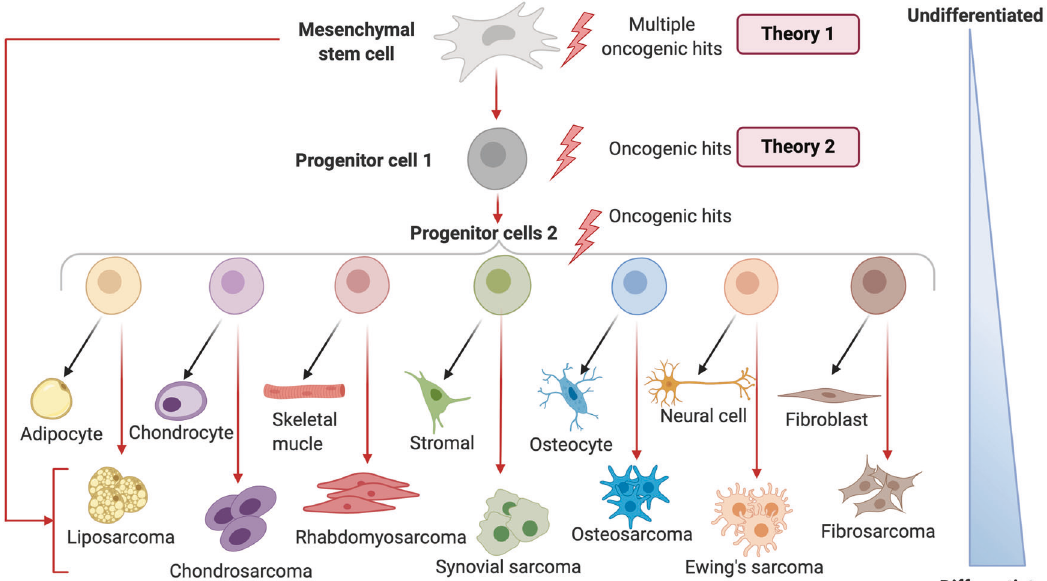
Fig. 6 Mesenchymal stromal/stem cell (MSC) differentiation and sarcomagenesis. Schematic representation of malignant transformation of MSCs into several sarcoma subtypes driven by several oncogenic hits (red arrows). During normal development, MSCs mature through different stages (progenitor cells) towards a fi nal differentiated cell such as an adipocyte, chondrocyte, osteocyte, skeletal myocyte, fi broblast, neural, and stromal cell. Theory 1 suggests that oncogenic hits occur in primitive MSCs; theory 2 suggests that oncogenic hits occur in progenitor cells which drives their malignant transformation. The two theories are not mutually exclusive but they feed into a model where sequential genomic alterations in a primitive MSC and/or its progenitor cells result in an accumulation of oncogenic hits followed by malignant